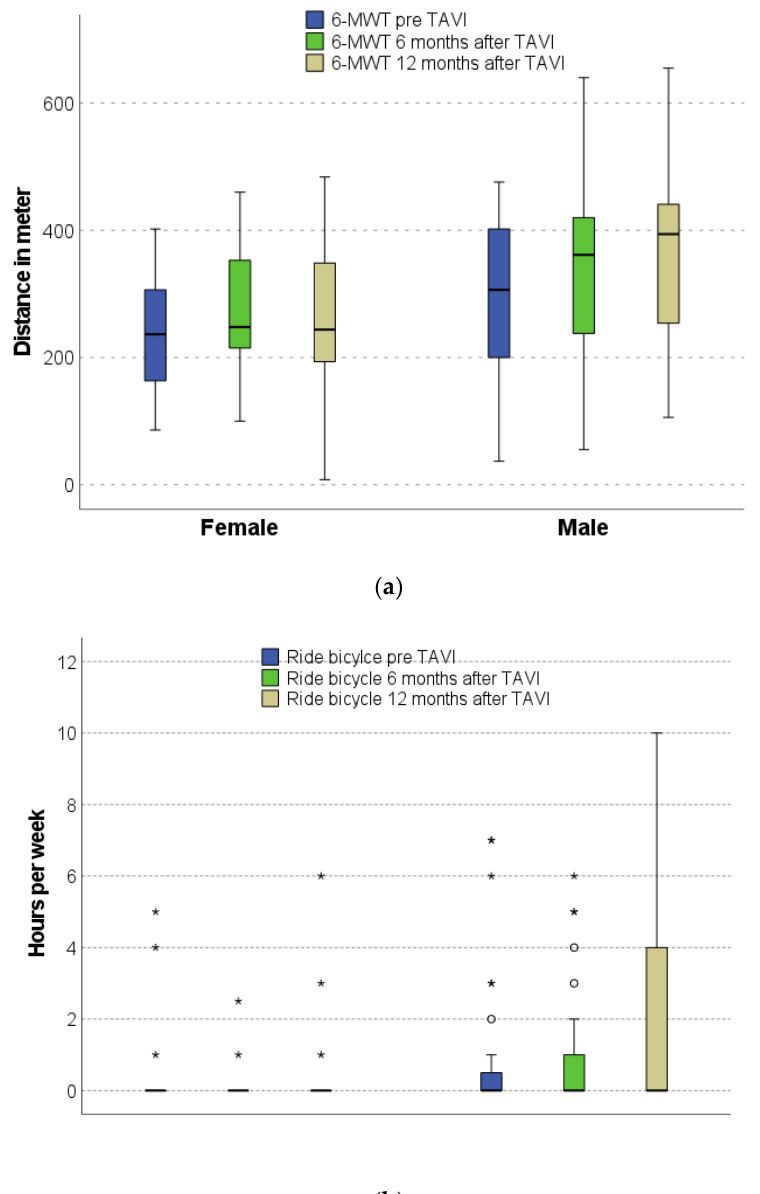
Figure 3. Sex-specific changes in physical performance over 12 months: ( a ) Six-minute walking test (6-MWT); ( b ) bicycle riding. The * means outliers.